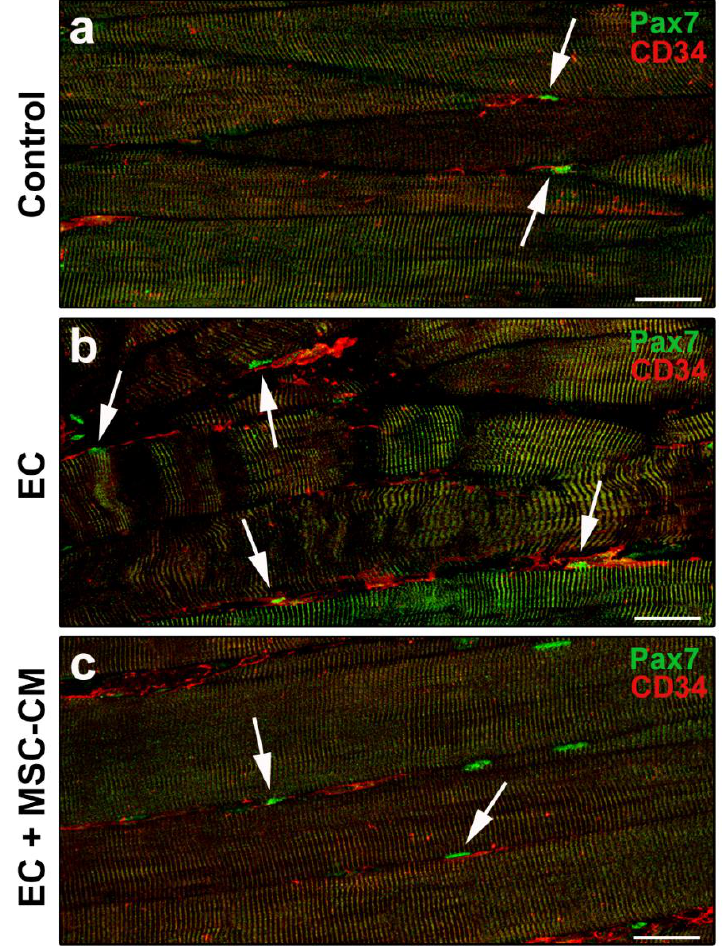
Figure 6. Morphological evaluation of telocytes and satellite cells (SCs) interaction in formalin-fixed and paraffin-embedded tissue sections from control EDL muscles, EDL muscles damaged by ex vivo forced eccentric contraction (EC) and EDL muscles damaged by EC in the presence of bone marrow-mesenchymal stromal cell (MSC) conditioned medium (EC + MSC-CM). ( a–c ) Representative confocal immunofluorescence images of muscle tissue sections immunostained with antibodies against Pax7 (green) and CD34 (red). Arrows indicate the presence of CD34 + telocytes in the close vicinity of Pax7 + SCs. Images are representative of at least 3 sections from each of 4 control, 4 EC and 4 EC + MSC-CM muscles. Scale bars = 25 μm.